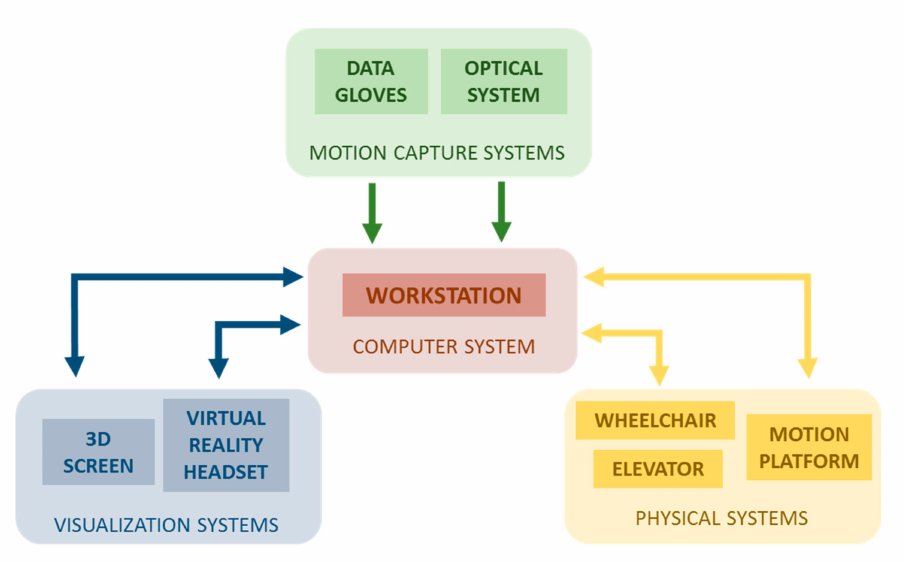
Figure 5. Scheme of the relationships between the four di ff erent types of devices that make up the VR